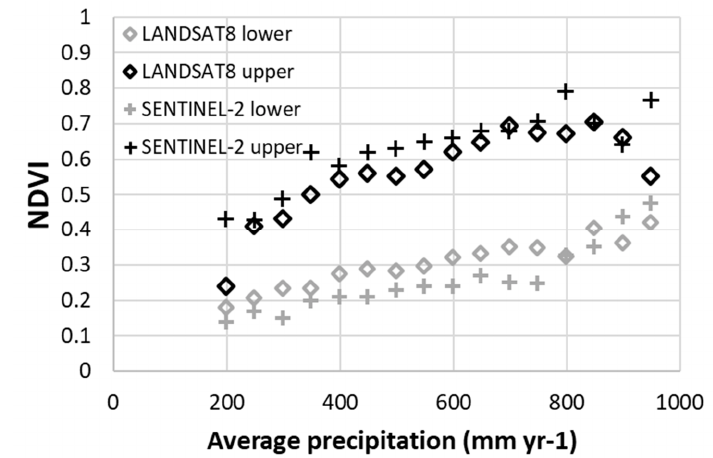
Figure 5. Comparison of the lower and upper precipitation-sensitive dynamic thresholds at different spatial scales of analysis. Comparison between the lower 10th quantile (gray) and upper 95th quantile (black) thresholds from an analysis of LANDSAT-8 (diamonds) and Sentinel-2 (pluses) products.